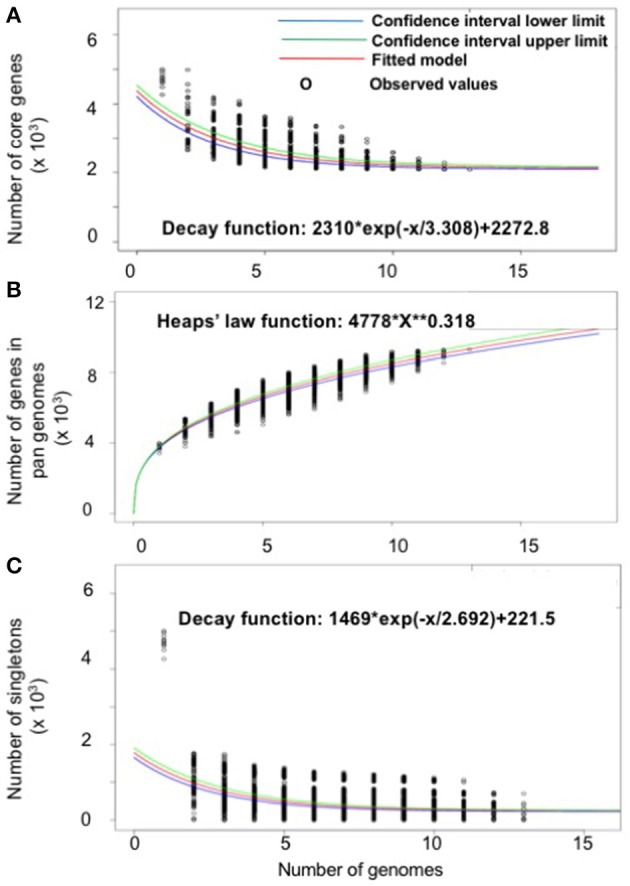
Pan, core, and singleton genome evolution according to the number of selected Serratia genomes. (A) Number of genes (pan-genome) for a given number of genomes sequentially added. (B) Number of shared genes (core genome) as a function of the number of genomes sequentially added. (C) Number of unique genes (accessory genome) for a given number of genomes sequentially added.